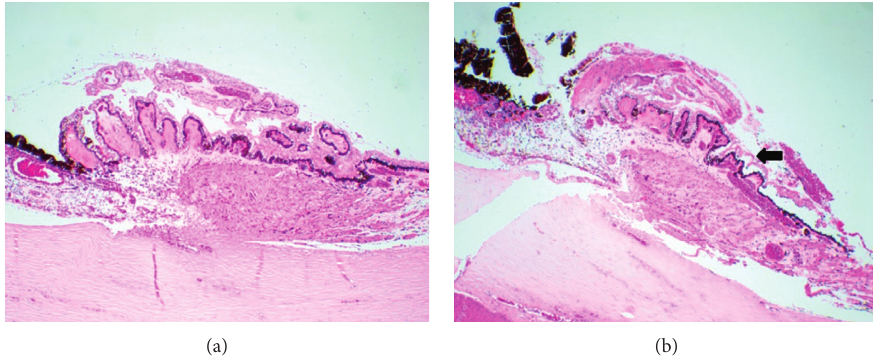
Figure 5: Light microscopy of ciliary processes (40x). (a) Normal ciliary processes showing normal-appearing stroma and the pigmented and nonpigmented ciliary epithelium. (b) IDCP-treated ciliary processes showing destruction of the nonpigmented epithelium and its detachment from the pigmented epithelium (straight